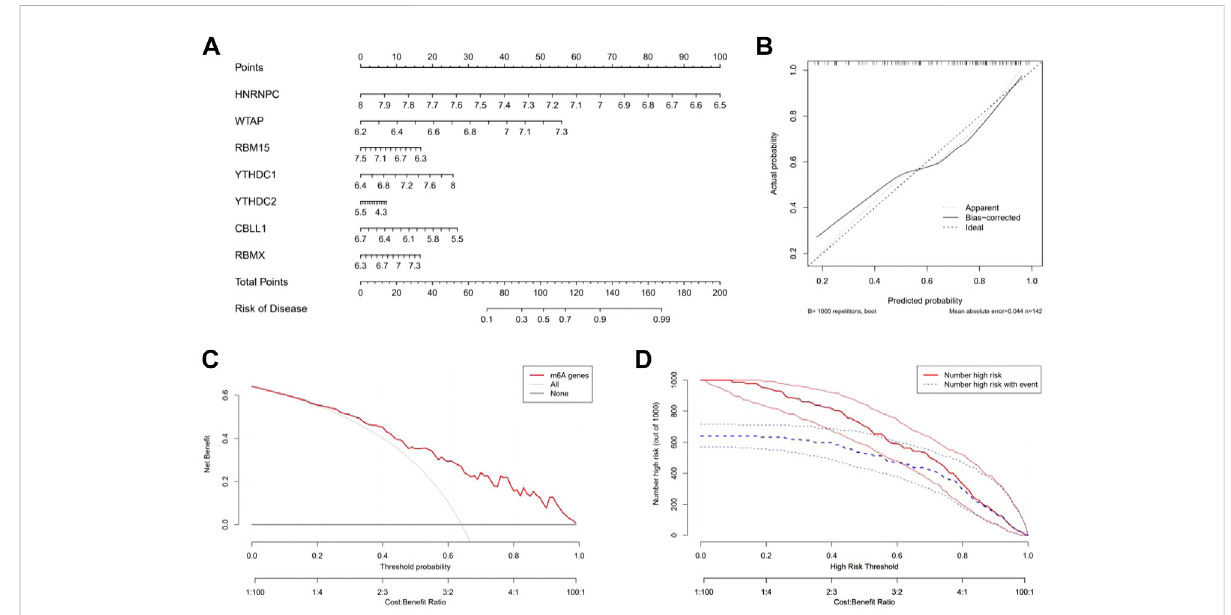
FIGURE 4 Construction and bene fi t prediction of the nomogram model. (A) Nomogram plotted to predict the occurrence of epilepsy based on seven signi fi cant m6A regulators. (B) Calibration curveof thenomogramshowingthe consistency between thepredicted and true occurrence of epilepsy. (C) Analysis of whether the nomogram model is bene fi cial to patients with epilepsy. (D) Clinical impact curve to show the clinical impact of the nomogram model.